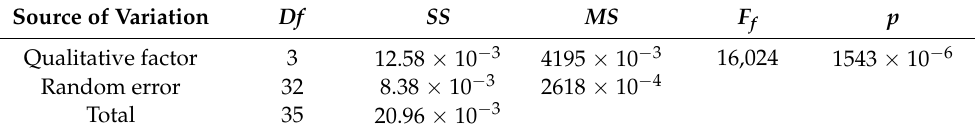
Table 8. Single factor analysis of variance calculations results.